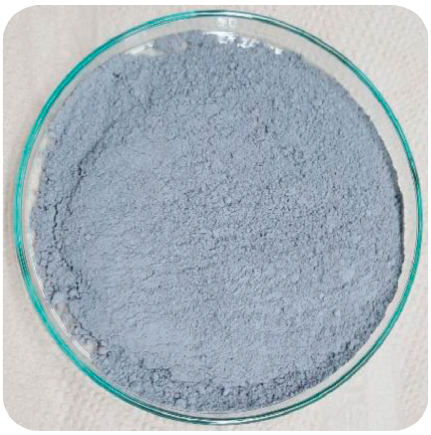
Figure 1: Wheat straw ash. Table 1: Chemical and physical properties of OPC and WSA.